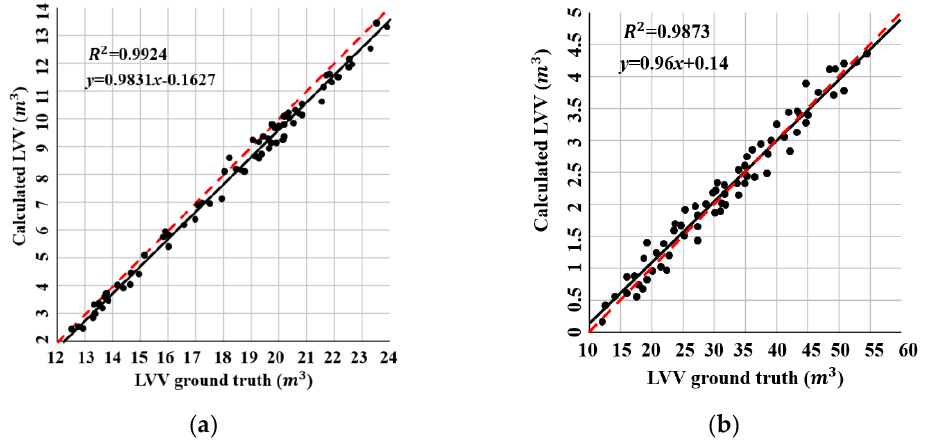
Figure 11. The validation LVV calculation results for two-point cloud datasets. ( a ) The validation